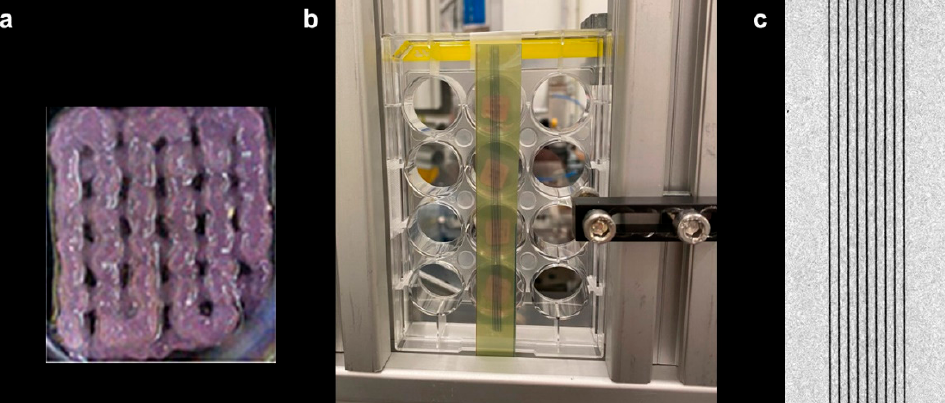
Figure 1. The 3D bioprinted sample ( a ) mounted for irradiation vertically in a 24-well plate ( b ). The dark stripes, caused by the peak doses of MRT, are visible on the self-developing Gafchromic™ film placed on the back of the 24-well plate, behind the samples, to record the irradiation pattern. Microphotograph of the Gafchromic™ film after irradiation ( c ).